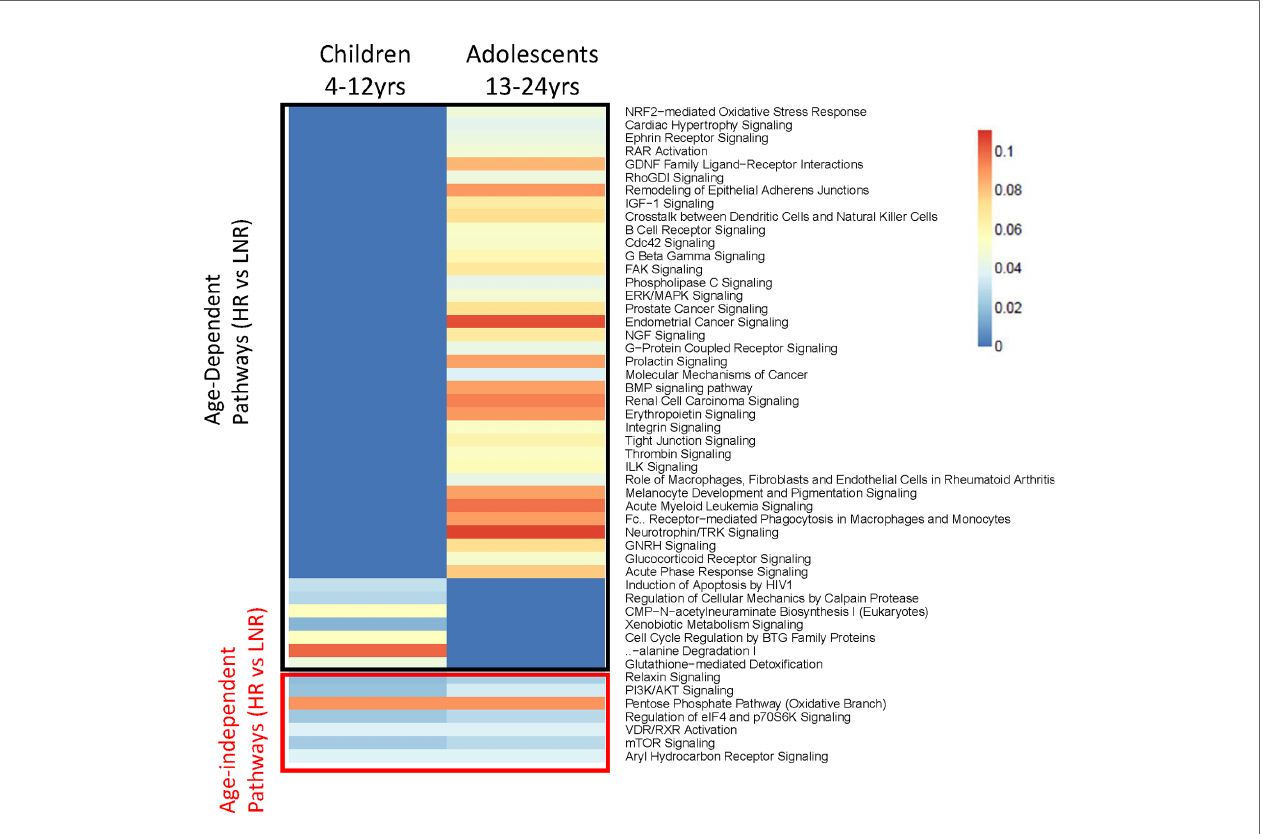
FIGURE 5 | Pathway Analysis in two Age Groups at Baseline. Heatmap showing statistically signi fi cant canonical pathways (IPA) (both uniquely and commonly) regulated in high responders versus low/non-responders in the two age groups (4-12 years and 13-24 years) at baseline. Genes with an adjusted p-value <0.05, |FC|>1.3 and associated with canonical IPA pathway were used for analysis. Heat scaling refers to results from over-representation test performed using Fisher Exact Test (red indicating greater gene enrichment in the pathway). All pathways shown are statistically signi fi cant (p value < 0.05) in one or both